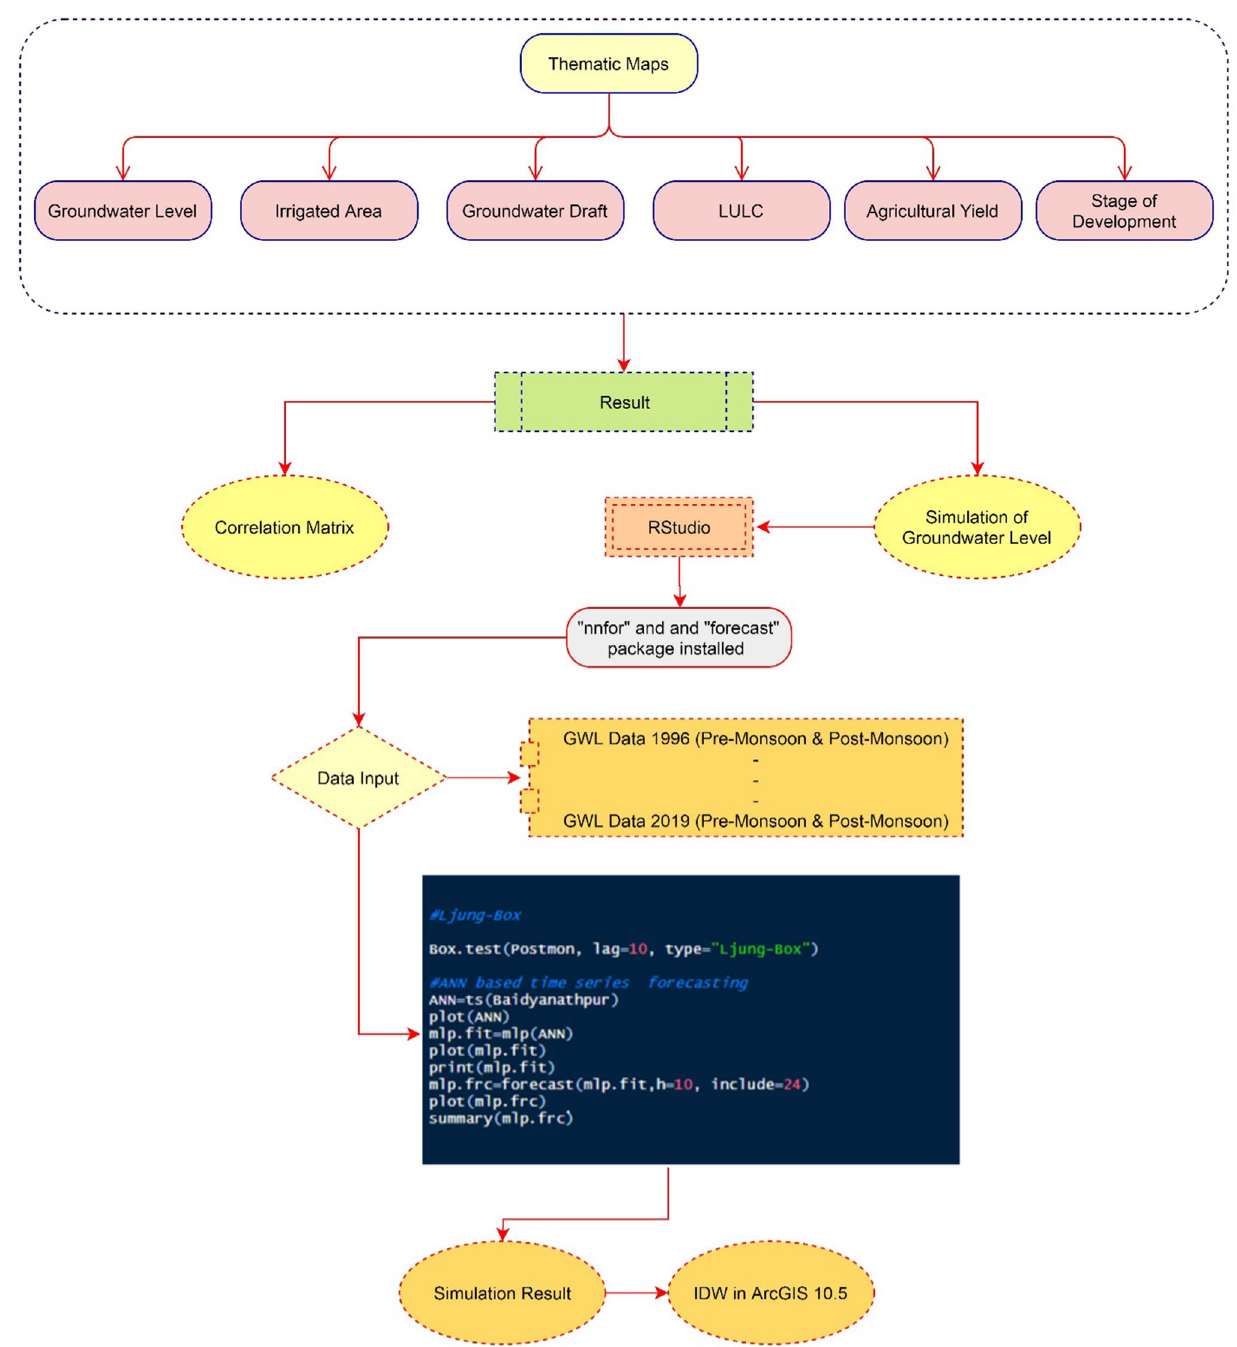
Fig. 8 Schematic presentation of the entire